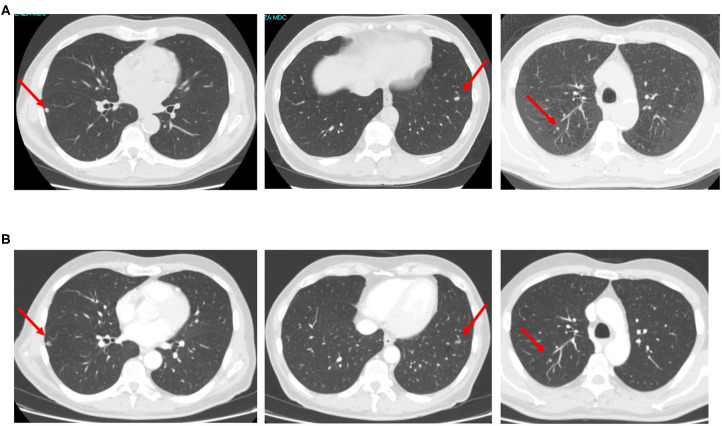
CT scan images showing bilateral lung metastases early relapsed after adjuvant chemotherapy (A) and re-evaluated after first-line aflibercept/chemotherapy (B).